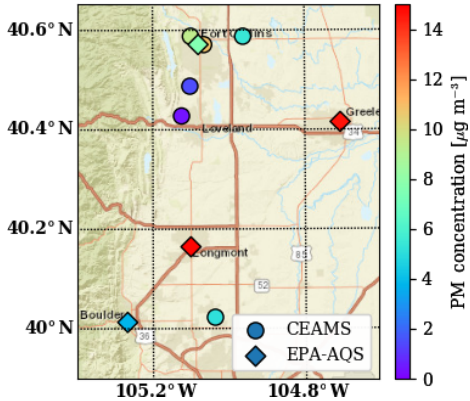
Figure 3. Average PM 2 . 5 concentration measured by CEAMS par- ticipants (48h average) and at AQS monitoring sites (24h average) in northern Colorado for 13 November 2017. Map generated using World Street Maps (credit: Esri, HERE, Garmin, USGS, Intermap, INCREMENT P, NRCan, Esri Japan, METI, Esri China – Hong Kong, NOSTRA, ©OpenStreetMap contributors, and the GIS user community). ©OpenStreetMap contributors 2019. Distributed un- der a Creative Commons BY-SA